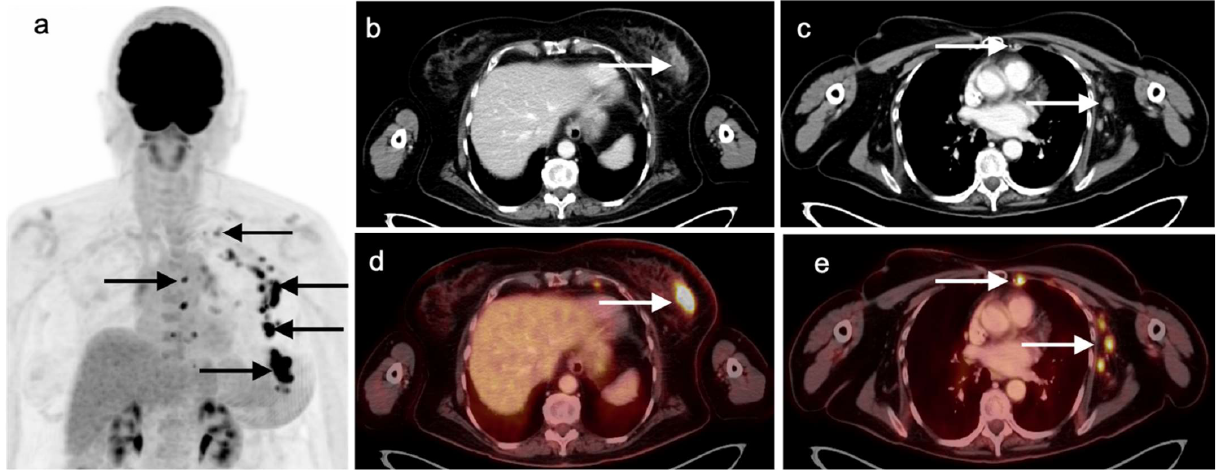
Figure 20. A 77-year-old female with left breast hormone-receptor-negative, HER2-positive invasive ductal carcinoma with biopsy-proven left axillary nodal metastatic disease. FDG PET-CT for initial staging demonstrates a hypermetabolic left breast mass (inferior-most black arrow on the maximal intensity projection image ( a ) and white arrows on axial CT ( b ) and fused FDG PET-CT images ( d ). Associated left axillary, left supraclavicular, left internal mammary, and mediastinal nodal metastatic disease is noted (superior black arrows on ( a ), white arrows at representative lesions on ( c , e )).